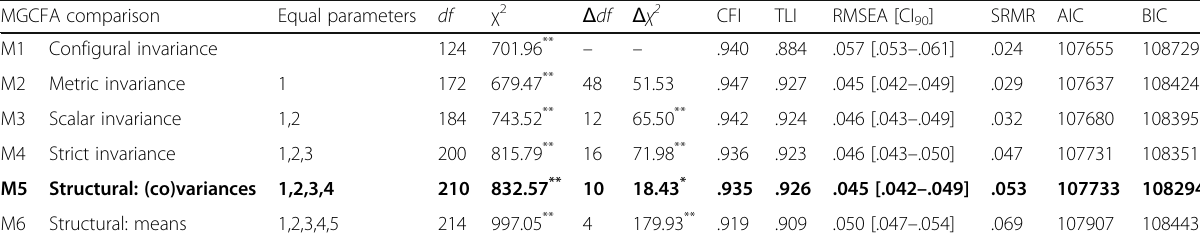
Table 3 Measurement invariance of SPF-IRI across gender groups based on ESEM MGCFA